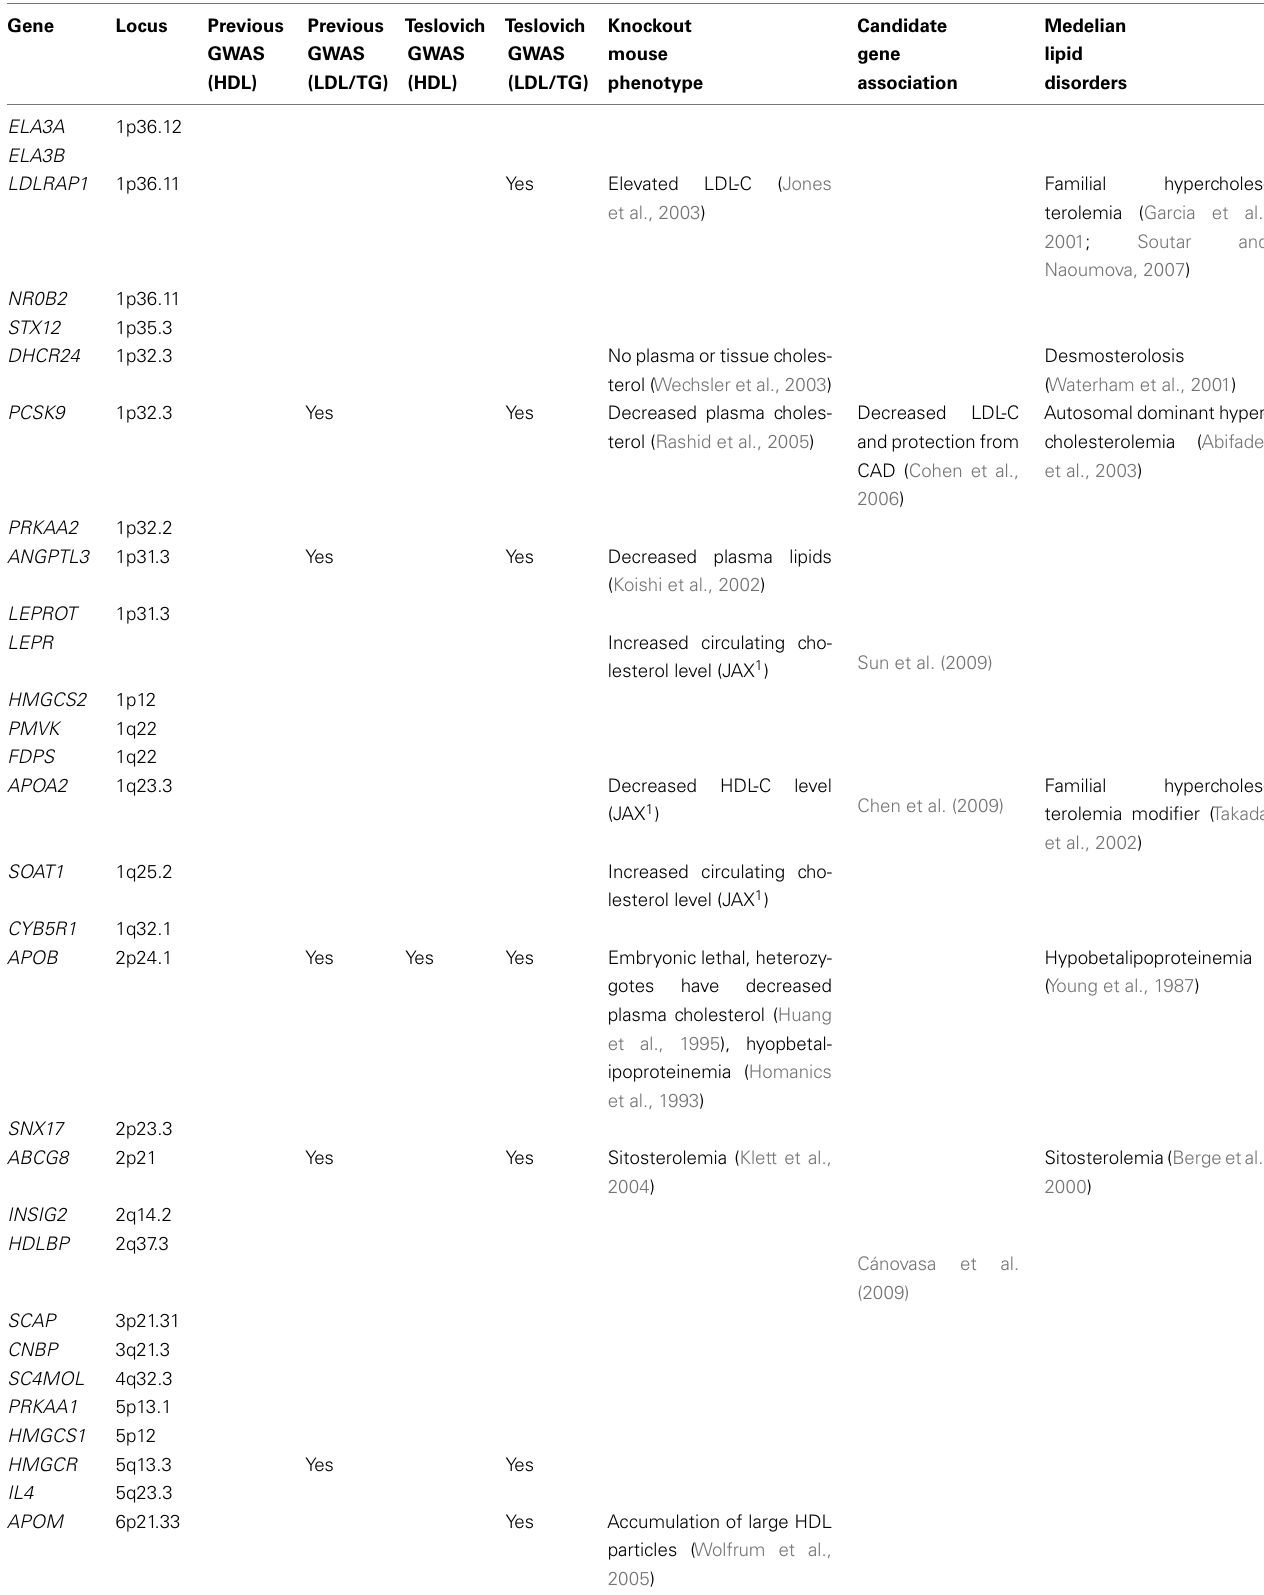
Table 2 | List of genes in the sterol transport/metabolism pathway with additional evidence of association with lipid traits. Gene